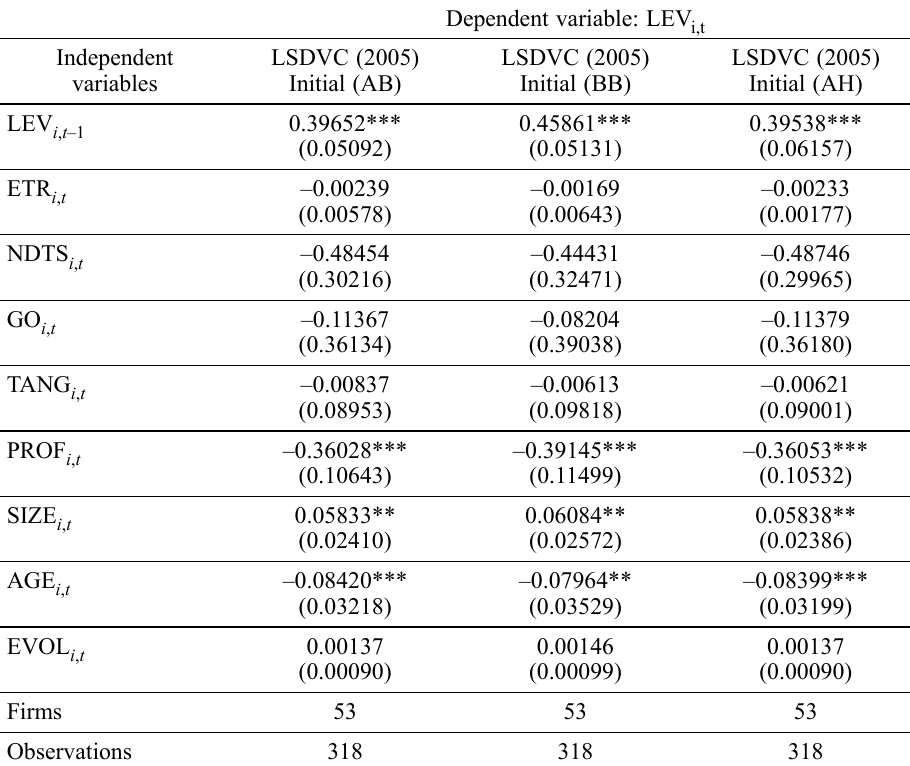
Table 4. Debt determinants – LSDVC (2005) dynamic